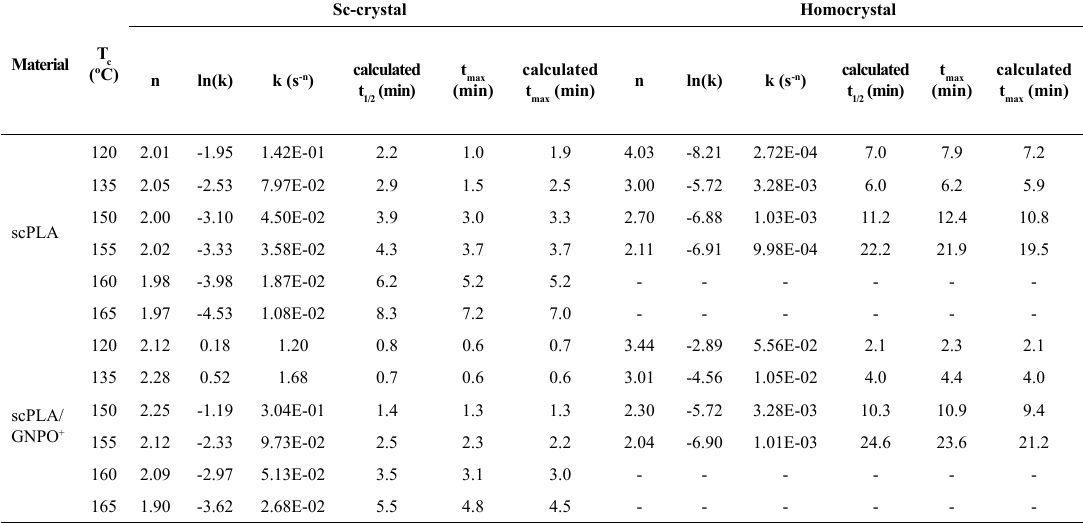
Table 2. Avrami kinetic parameters for the crystallization of scPLA and scPLA/GNPO+ nanocomposite.